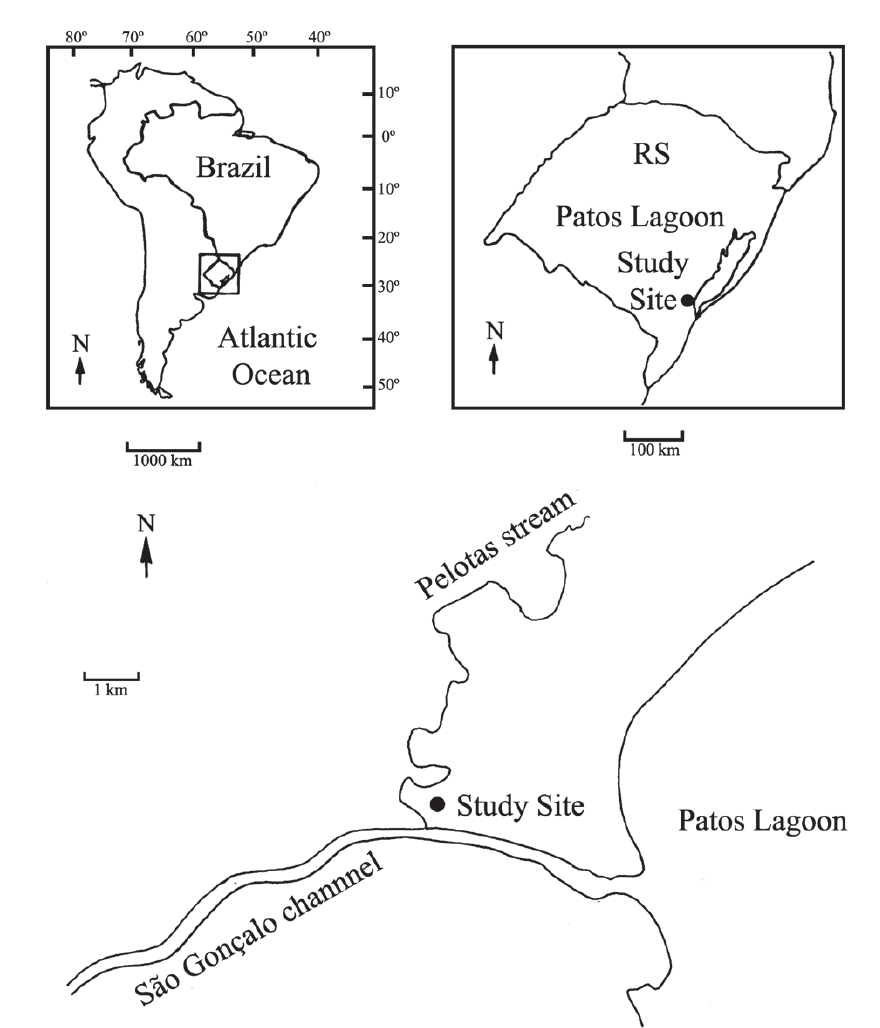
Fig. 1. Map of study area showing sampling location for Cynopoecilus melanotaenia between the São Gonçalo channel and Pelotas stream, State of Rio Grande do Sul (RS),